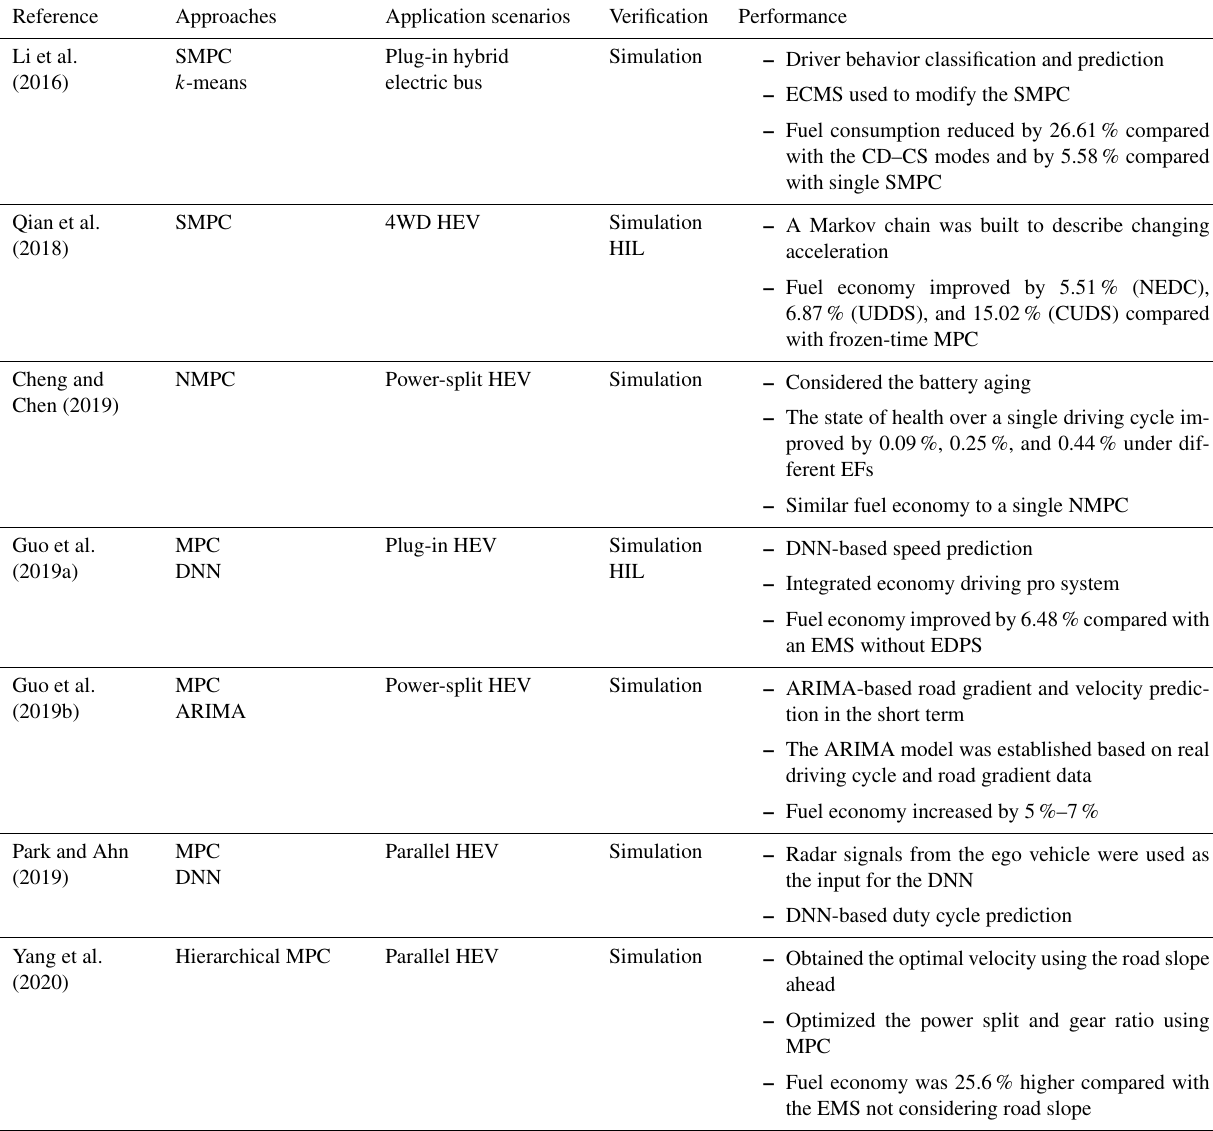
Table 12. Summary of the exemplary works on MPC-based